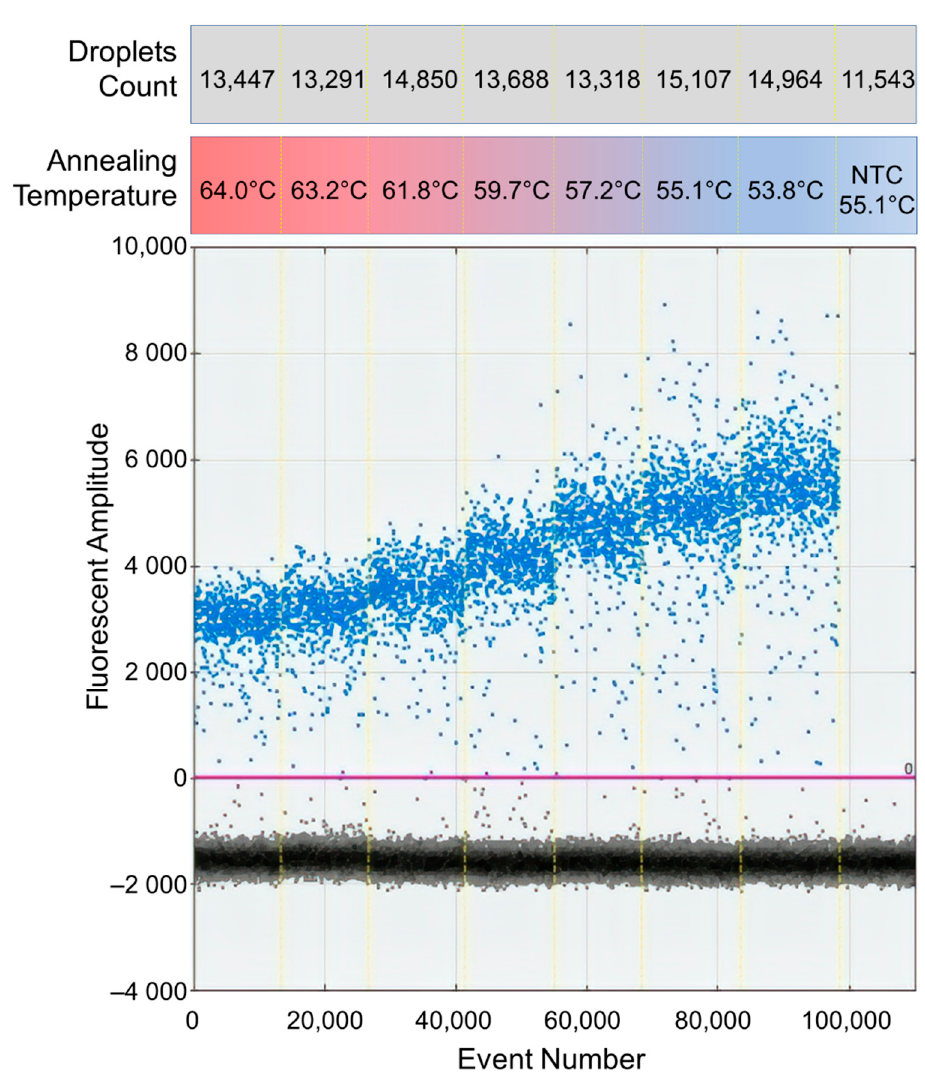
Figure 2. Temperature gradient PCR result of FAM/Tamra-labeled probes. The annealing tempera- ture was varied from 53.8 °C to 64.0 °C. X-axis represents the total number of droplet events. Y-axis represents the detected fluorescent amplitude. NTC represents negative control. Total numbers of droplets count per reaction are shown in the gray box.